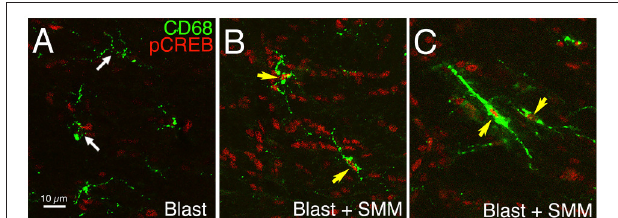
FIGURE 2 | Images showing the effect of SMM-189 treatment on pCREB expression in microglia in the left internal capsule after blast. Confocal images showing immunostaining for pCREB and CD68 in a blast alone mouse (A) compared to a SMM-189-treated blast mouse (B,C) at 3 days post blast. DAPI staining (not shown) was used to identify nuclei. The nuclei of all microglia lack prominent pCREB in the blast mouse (white arrows), but all are rich in pCREB in the SMM-189-treated mouse (yellow arrows). Note that some microglia exhibit prominent CD68 expression and a rod-like morphology (C) after SMM-189 treatment, and some of these are aligned parallel to axons descending from the cerebral cortex.